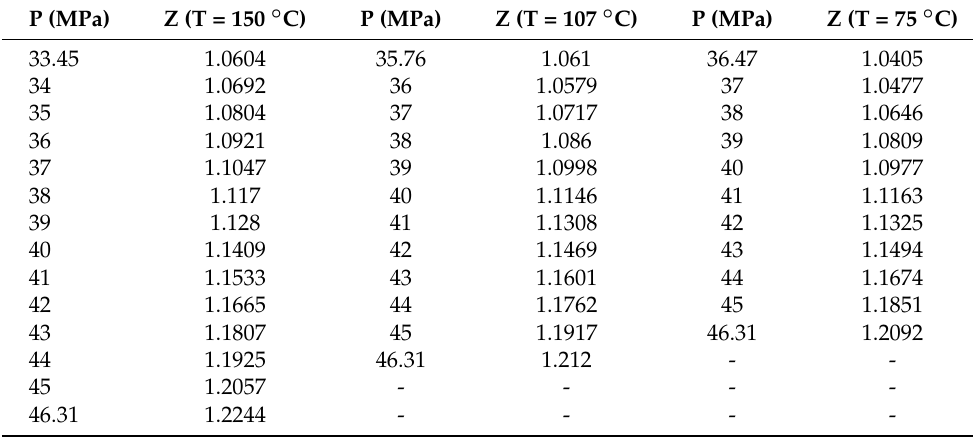
Table A3. Measured compressibility factors of sample 2 in the H2 field.